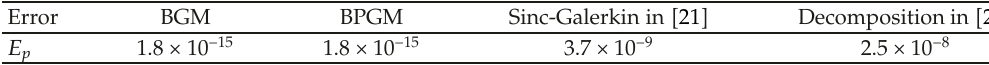
Table 3: Comparison between di ff erent methods for Example 5.2.